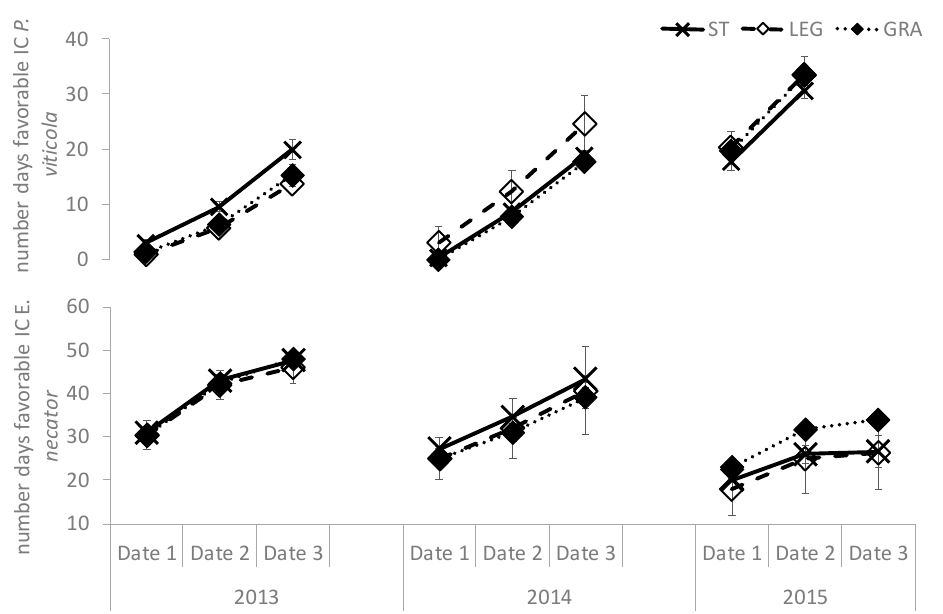
Figure 11. Accumulated number of days with a favorable IC for the development of downy and powdery mildew at each date of disease monitoring on the shoots, in the three soil management treatments. Values are the mean ± standard error.